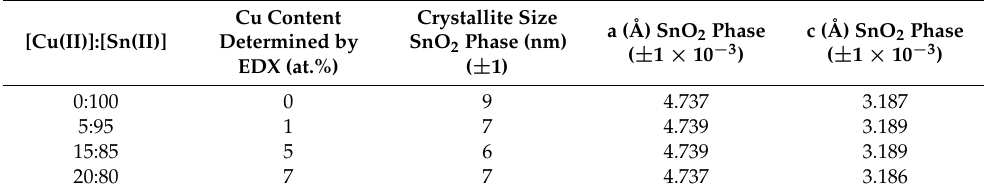
Table 1. Atomic percentages of Cu assessed by energy dispersive X-ray analysis (EDX), crystallite size and lattice cell parameters of the SnO 2 phase (determined by Rietveld refinement of the X-ray diffraction (XRD) patterns) of the samples synthesized from [Cu(II)]:[Sn(II)] molar ratios of 0:100, 5:95,